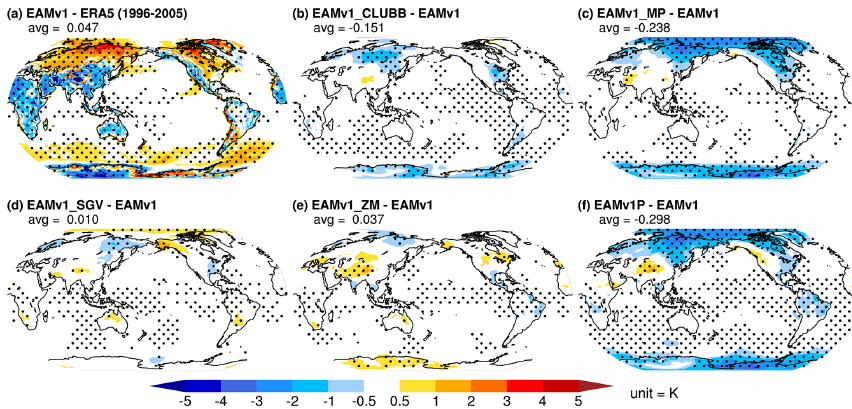
Figure 10. The 2m height air temperature (unit = K). The ERA5 reanalysis is used for the comparison with EAMv1.